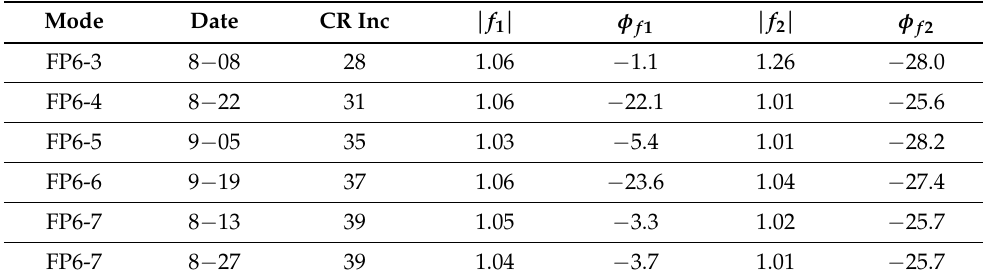
Table 1. PALSAR2 channel imbalance (magnitude and phase (in degree)).